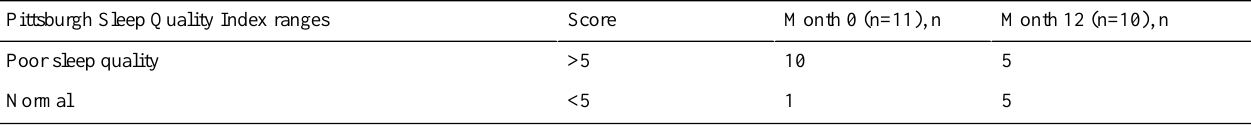
Table 16. Number of caregivers in each Pittsburgh Sleep Quality Index range group at months 0 and 12.